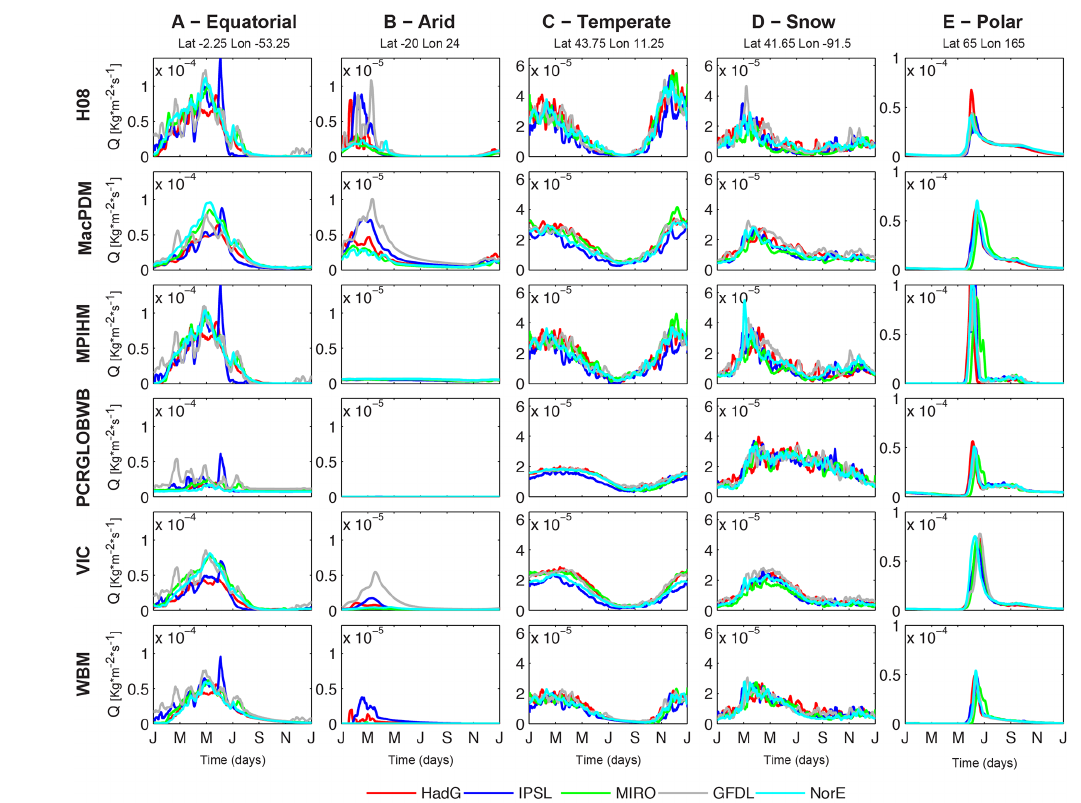
Figure A1. Inter-annual dynamics in mean daily runoff (smoothed with a 7-day moving average) relative to the period 1972–2005 for selected Köppen–Geiger region grid cells: A, Tropical ( − 2.25 ◦ N, − 53.25 ◦ E) Northern Brazil; B, Arid ( − 20 ◦ N, 25 ◦ E) Botswana; C, Temperate (43.75 ◦ N, 11.25 ◦ E) Central Italy; D, Snow (41.65 ◦ N, − 91.5 ◦ E) Central USA; E, Polar (65 ◦ N, 165 ◦ E) northeastern Russia.